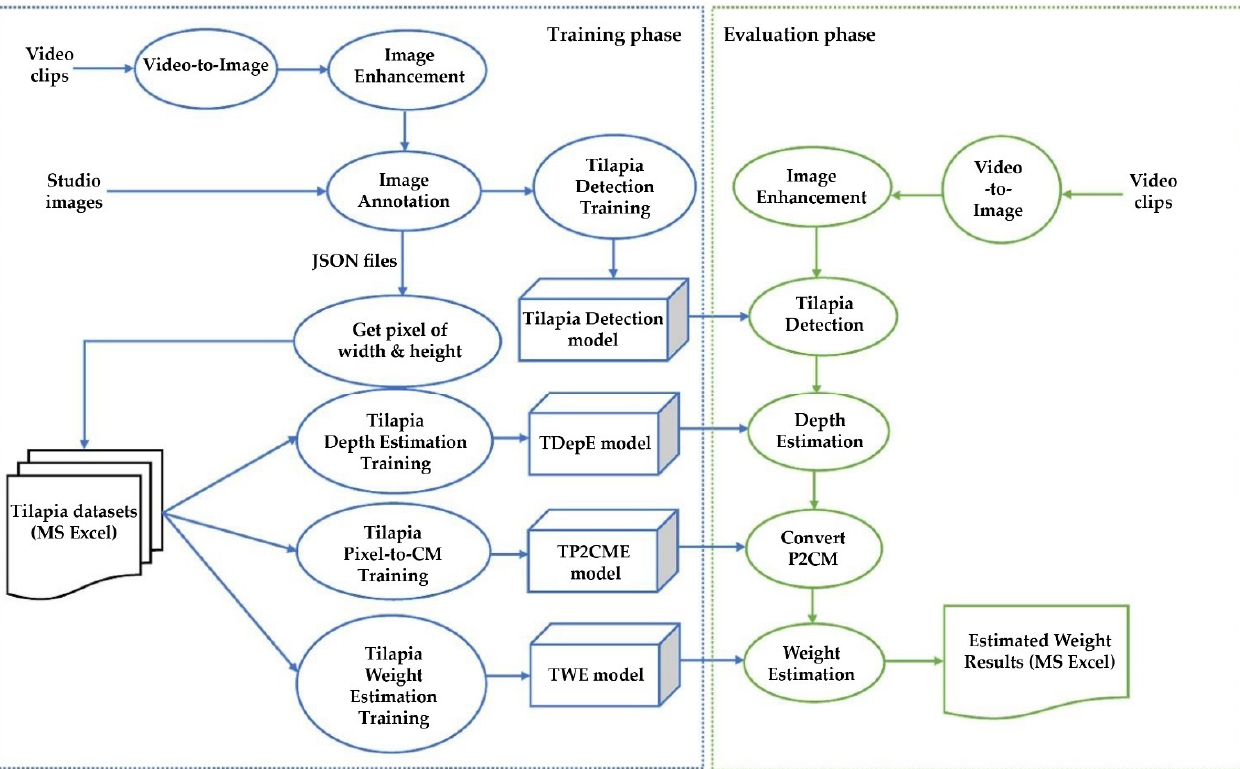
Figure 1. Proposed TWE-DRL algorithm.